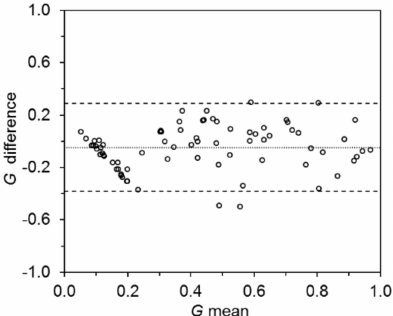
Figure 8. Bland and Altman plot of the GOHYLED